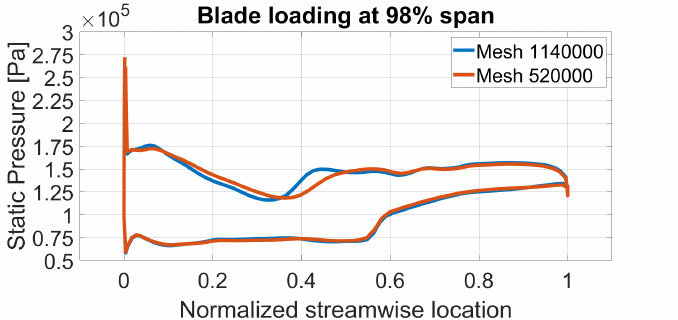
Figure 7. Mesh independence